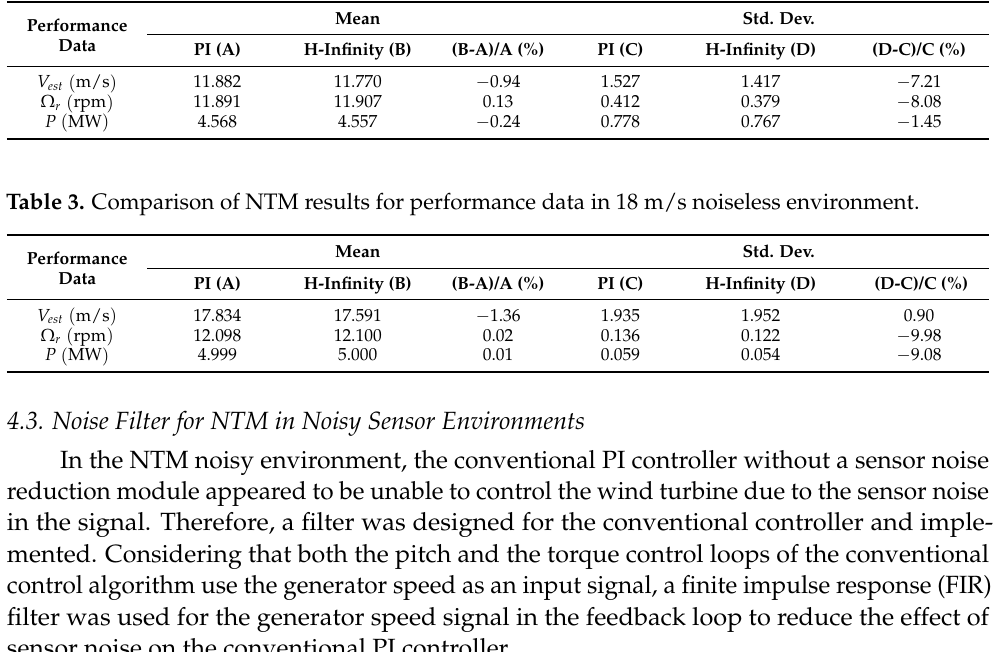
Table 2. Comparison of NTM results for performance data in 12 m/s noiseless environment.